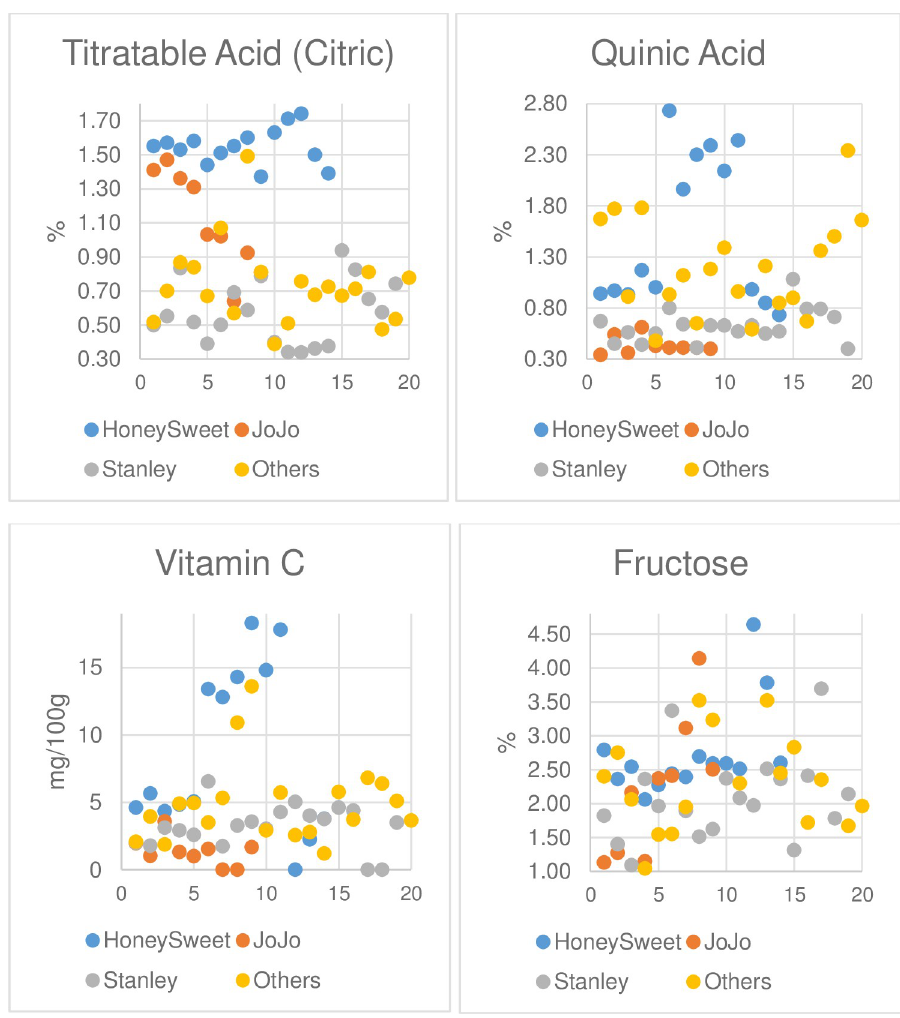
Fig 2. Distribution of values for individual fruit samples for four components. The three multilocation samples, ‘HoneySweet’ in blue, ‘Stanley’ in grey, ‘Jojo’ in orange and the other 20 cultivars in yellow, are graphed for Titratable Acid, Quinic Acid, Vitamin C and Fructose. ‘HoneySweet’ is consistently high for titratable acid, and ‘Stanley’ and ‘Jojo’ are consistently low for quinic acid. All the others overlap.